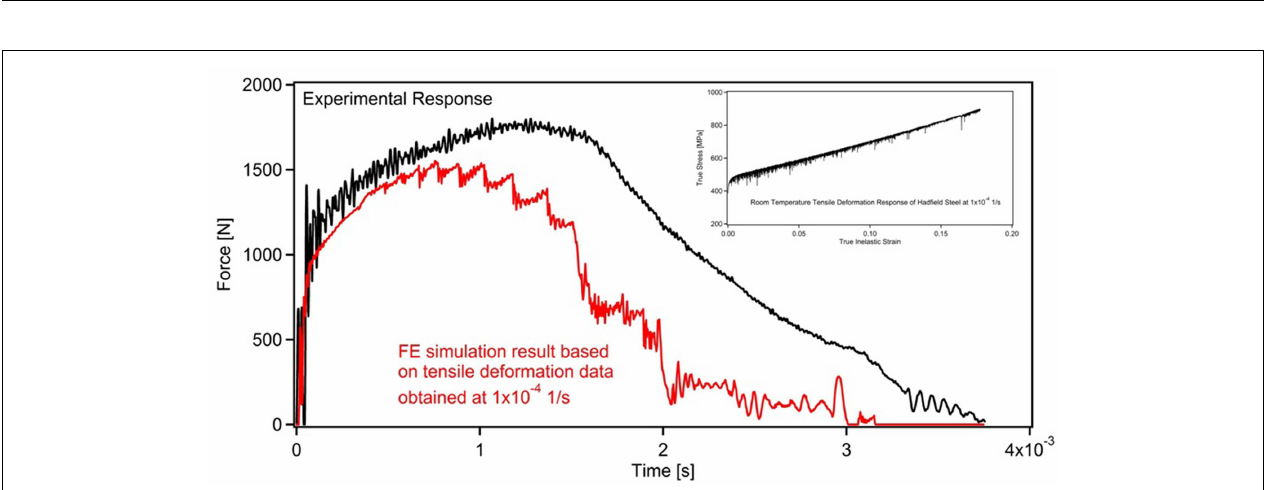
FIGURE 2 |The RT experimental impact response of Hadfield steel and the corresponding FE simulation result, where the flow rule was defined based on the experimental uniaxial tensile deformation response obtained at a strain rate of 1 × 10 − 4 1/s .